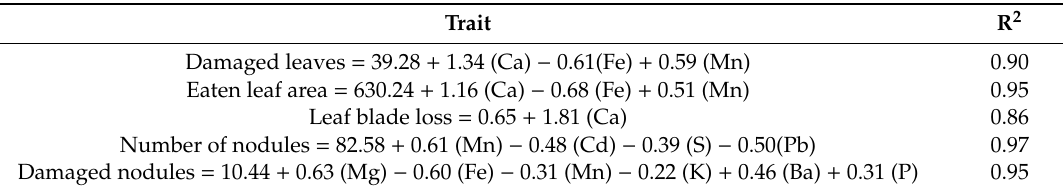
Figure 6. Principal component analysis of of element levels in V. faba organs, and soil contamination with petroleum-derived substances. Symbols as in Table 1, ap—aboveground parts, r—roots. Multiple regressions revealed that Ca and Mn had positive e ff ects on imago feeding while Fe exerted a negative e ff ect (Table 9). The percentage of damaged nodules was negatively a ff ected by Fe, Mn, and K and positively by Mg, Ba, and P. The negative e ff ect of Cd, S, and Pb was noted on the number of root nodules developed in V. faba plants. Table 9. Multiple regression equations ( p <